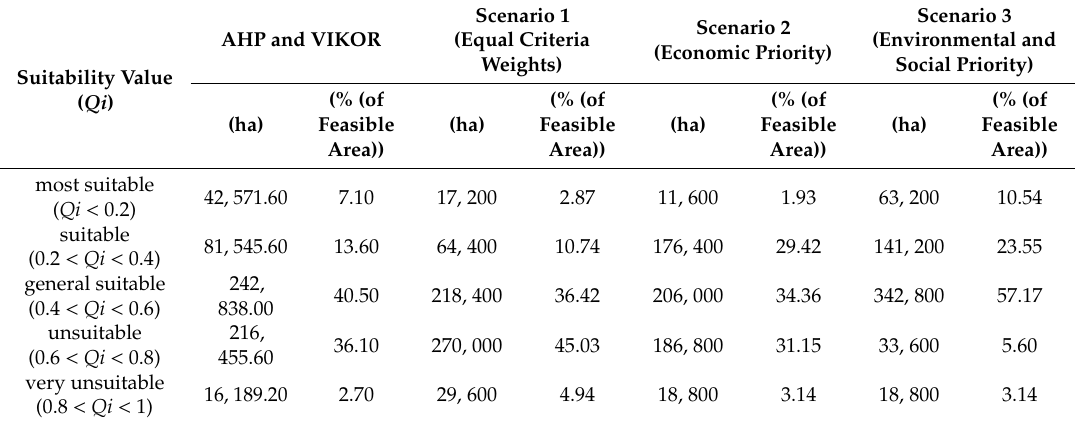
Table 4. Suitable area in Wafangdian City according to the Analytic Hierarchy Process (AHP) and sensitivity analysis